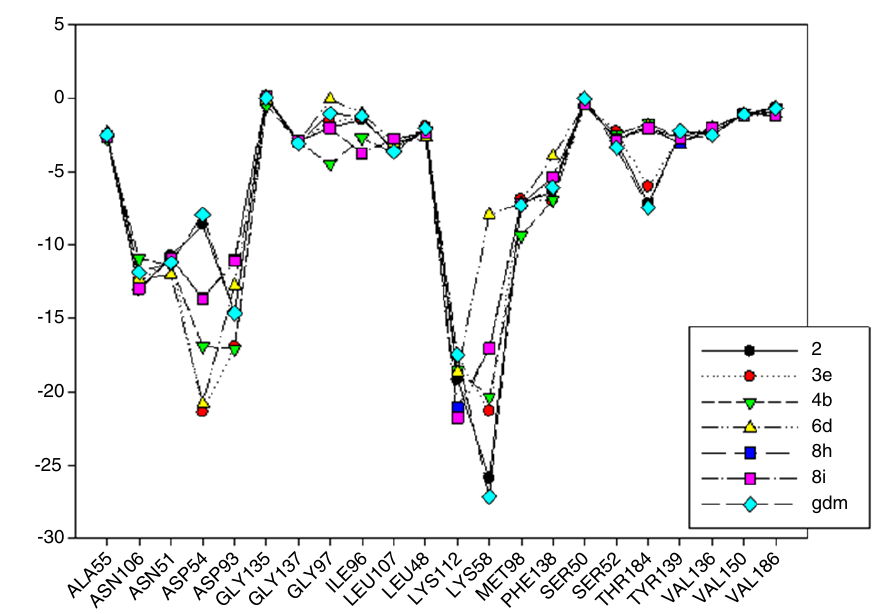
Figure 9. Interaction energies of geldanamycin analogues 2, 3e, 4b, 6 d, 8 h, 8i and